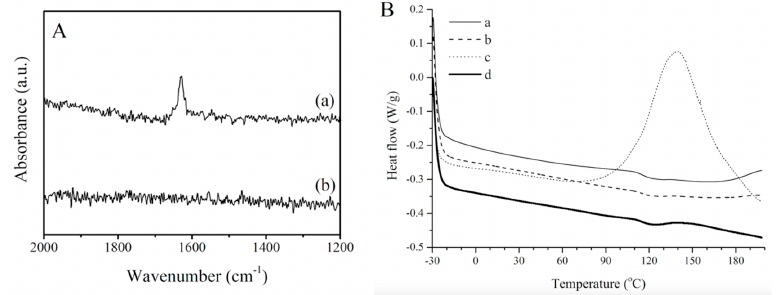
Figure 6. ( A ) Raman spectra of (a) tung oil fatty acid crude resin, and (b) tung oil fatty acid resin cured at 130 °C for 18 h. ( B ) DSC curves of (a) tung oil resin cured at 130 °C for 18 h, (b) tung oil fatty acid resin cured at 130 °C for 18 h, (c) tung oil methyl ester resin cured at 130°C for 18 h, and (d) tung oil methyl ester resin cured at 130 °C for 24 h.